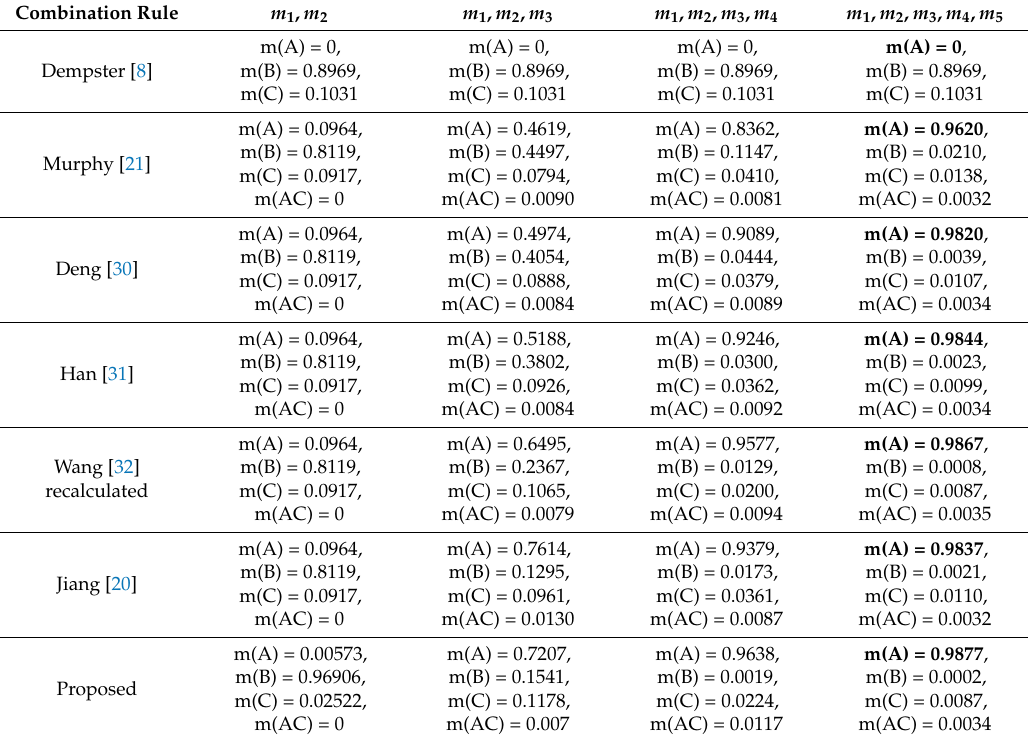
Table 4. Evidence combination results based on different combination methods for Example